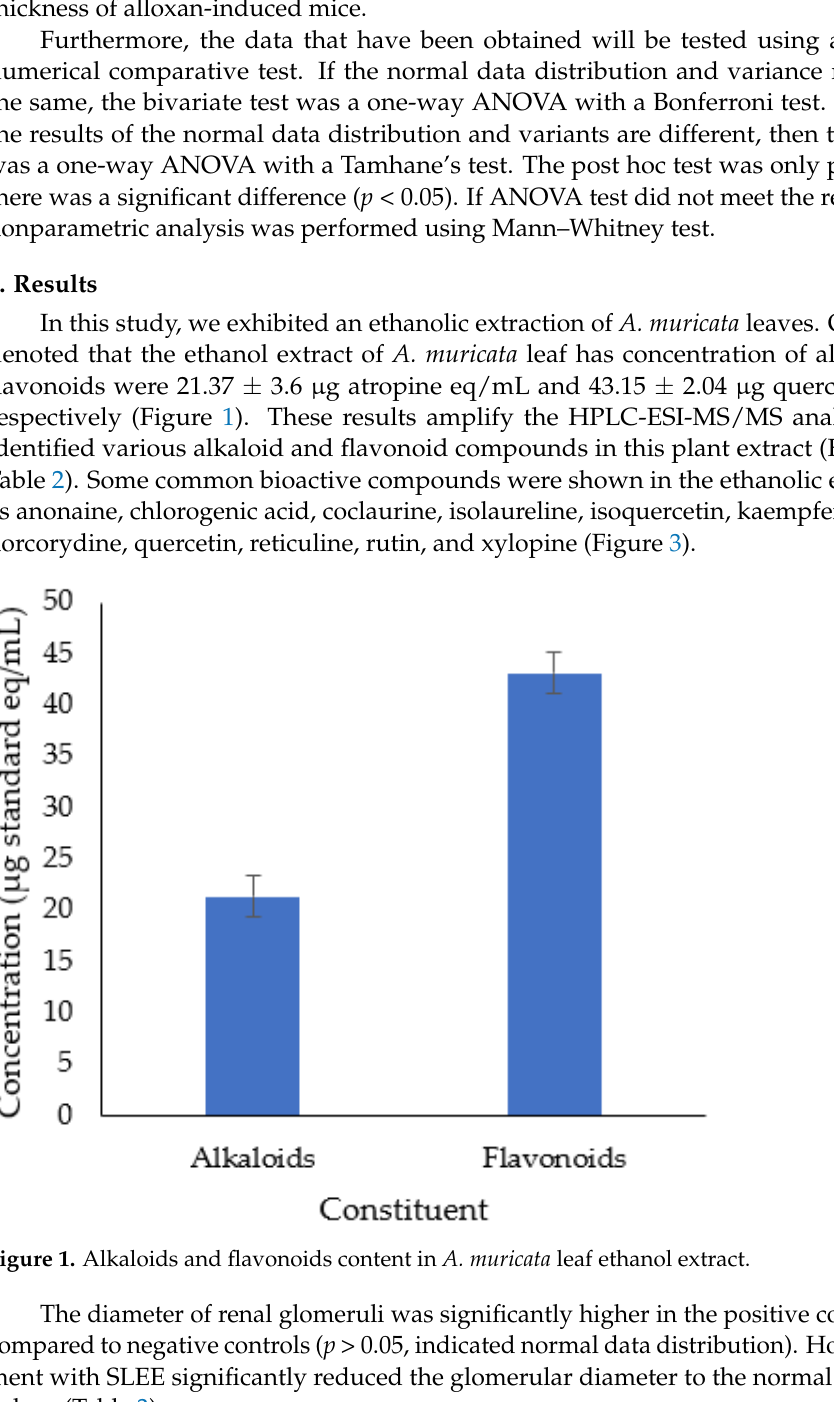
Figure 2. Chromatogram profile of bioactive compounds from A. muricata leaf ethanol extract using LC-MS/MS analysis. Table 2. Bioactive compound profiles from A. muricata leaf ethanol extracts identified by LC-MS/MS. No.